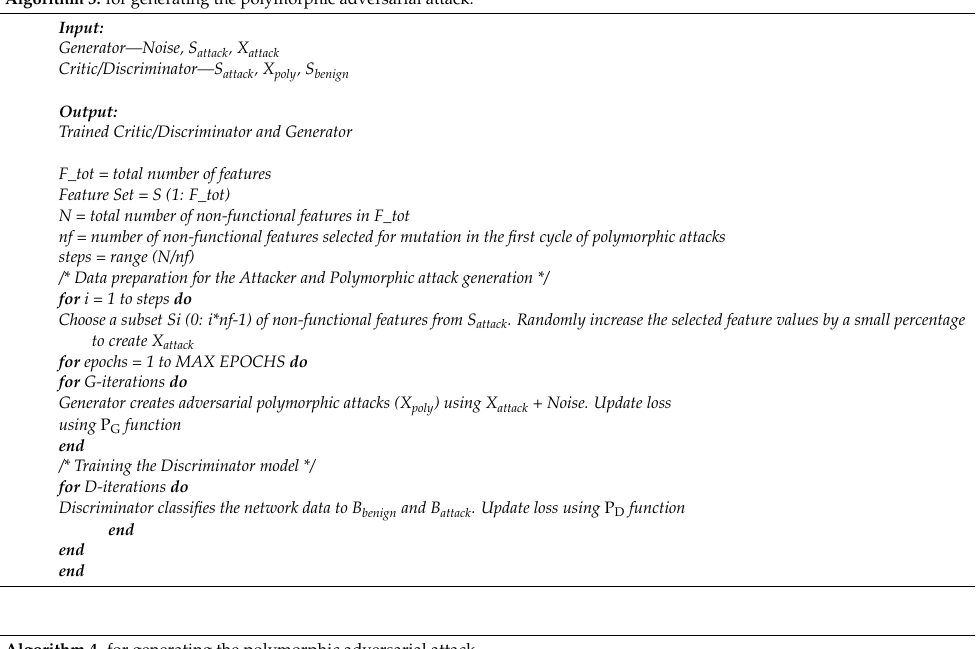
Algorithm 3. for generating the polymorphic adversarial attack.